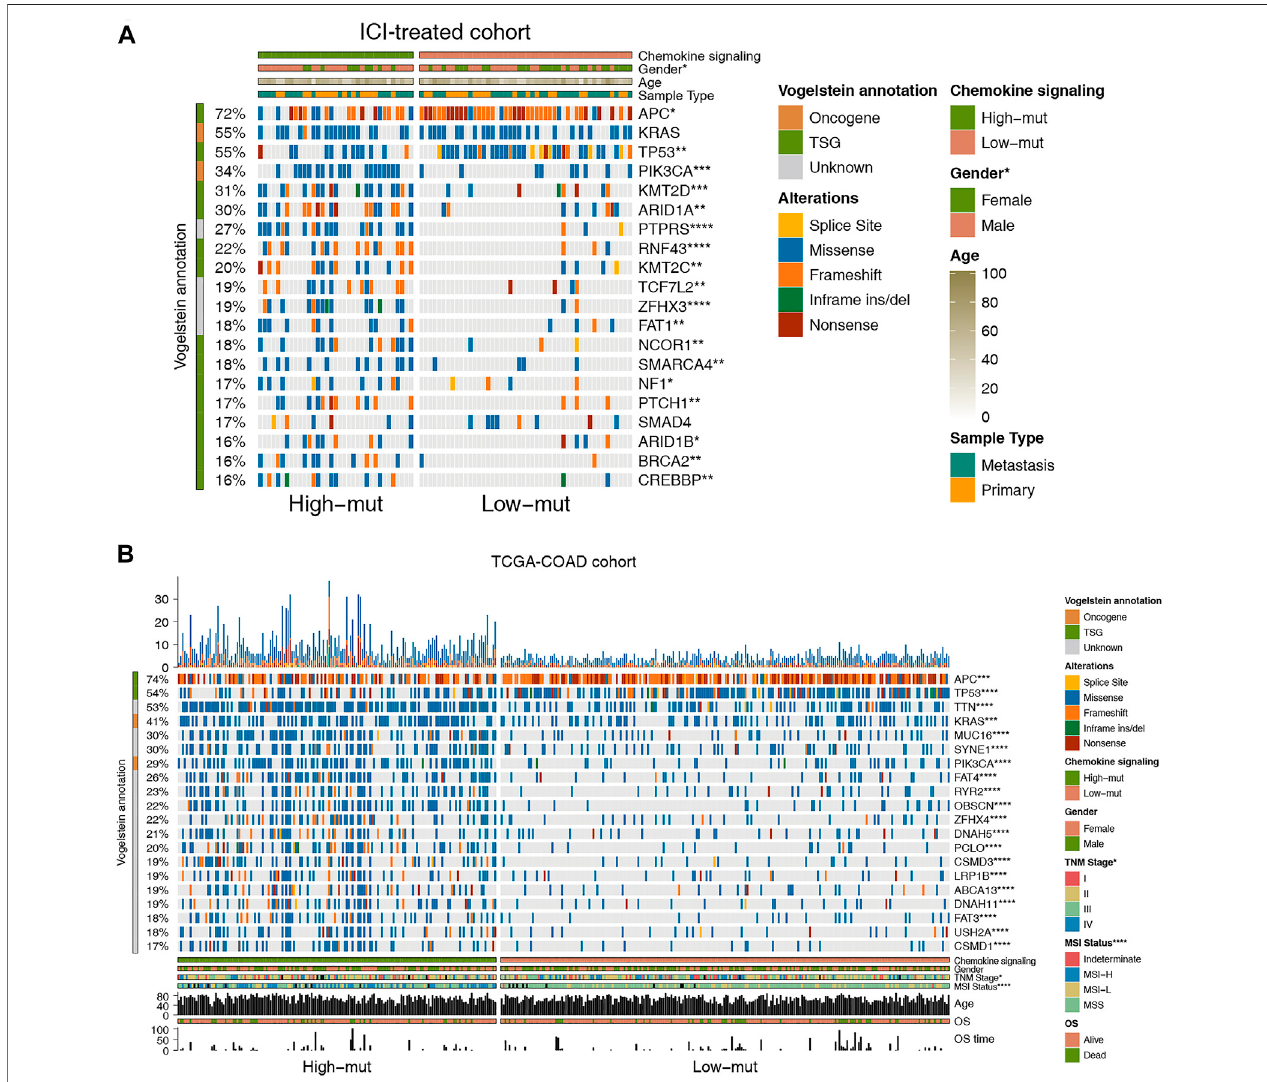
FIGURE2| Genomicpro fi lesofCOADpatientsintheICI-treatedcohort(Samsteinetal.,2019) (A) andtheTCGA-COADcohort (B) .The20geneswiththehighest mutation frequencies and corresponding clinical information are shown in the fi gure.